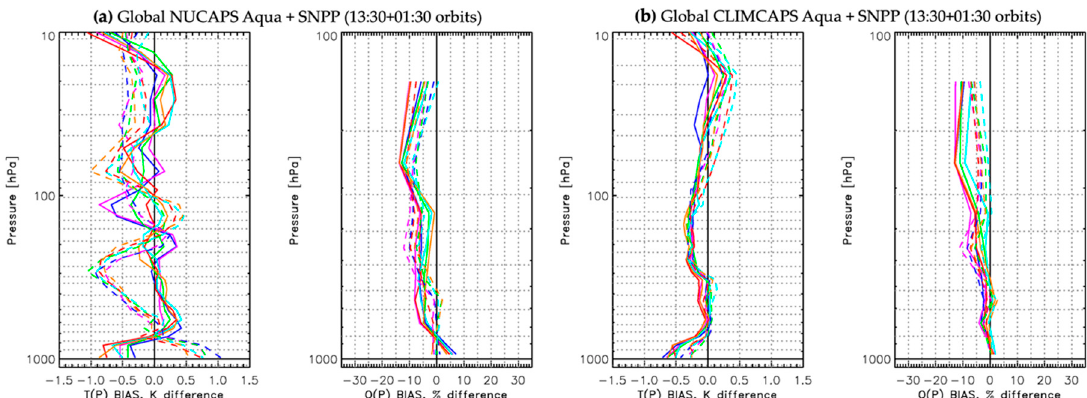
Figure 11. Global statistics of ( a ) NUCAPS from SNPP / CrIS (solid lines) and Aqua / AIRS (dashed lines) as well as ( b ) CLIMCAPS from SNPP / CrIS (solid lines) and Aqua / AIRS (dashed lines) as the bias with respect to ECMWF of temperature T(p) in units Kelvin and moisture Q(p) as percent profiles from six focus days.